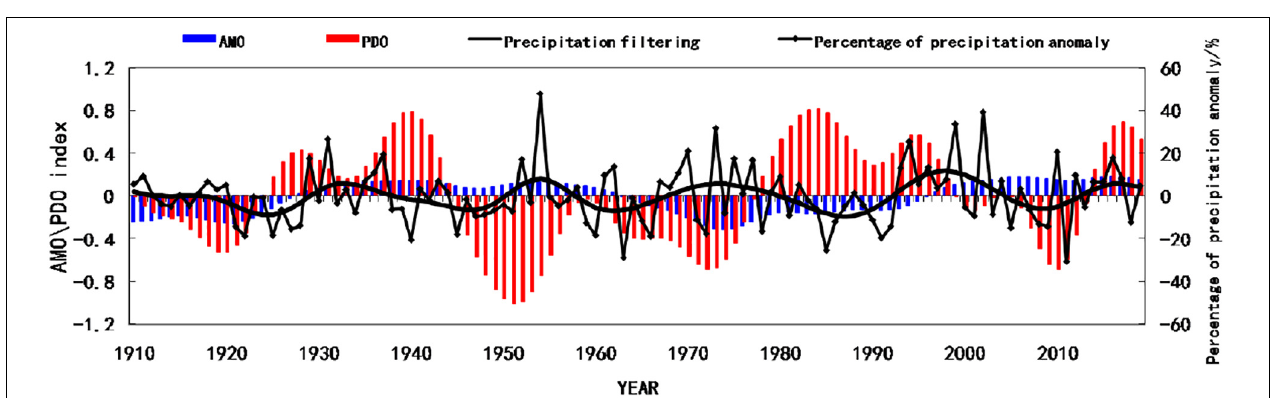
FIGURE 2 | Wavelet analyses for the precipitation anomaly percentage in Hunan flood seasons during 1910–2019. The shaded areas pass the significance test at 95% confidence level.